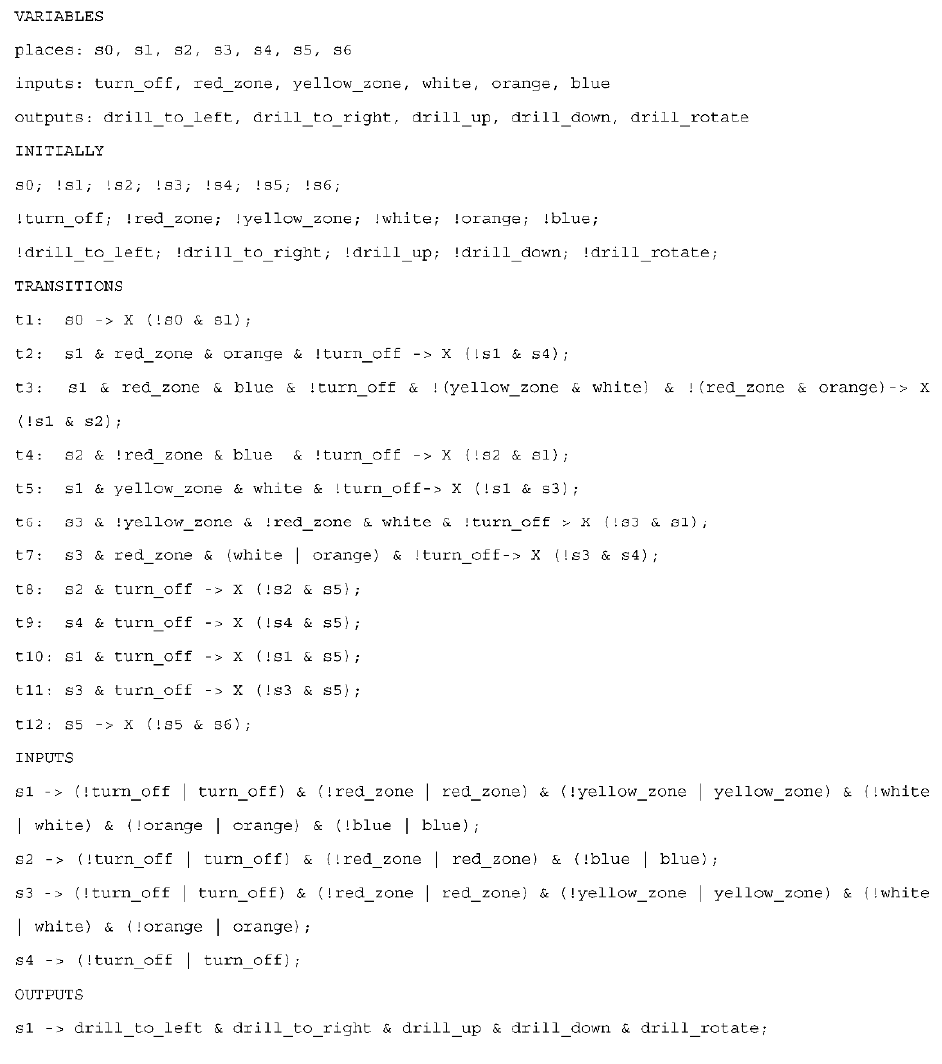
Figure 7. Rule-based logical model for the case study, with partial possible output signals.